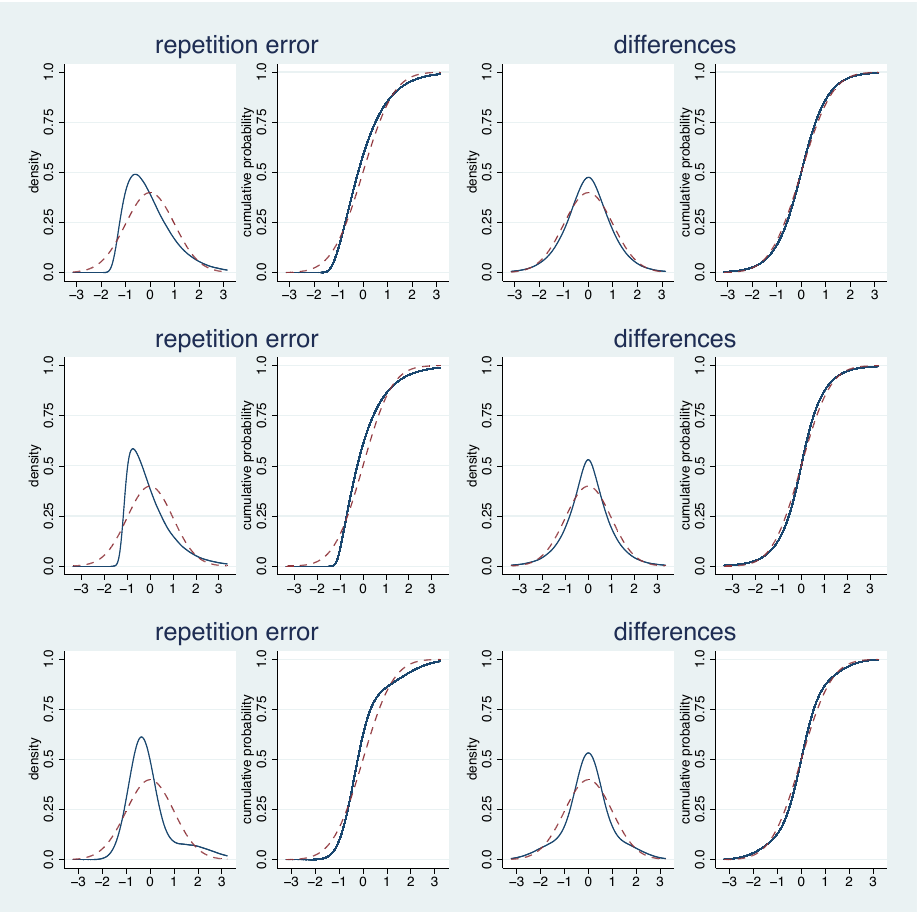
Figure 2. The density and cumulative distribution functions of three non-normal repetition error distributions and the corresponding functions for the distribution of the difference between two replicates. All distributions are standardized to a standard deviation of 1. The red dashed lines indicate the corresponding functions for a standard normal distribution as assumed when transforming the estimated standard